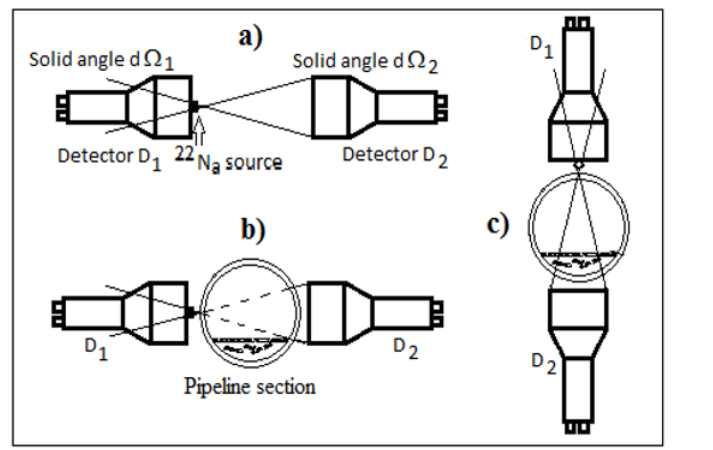
Figure 1. Scheme of the monitoring system geometry. a) Shows the positron source placed on D1 and the detectors in horizontal position. b) Same as a) but with the pipeline. c) Detectors in vertical position.